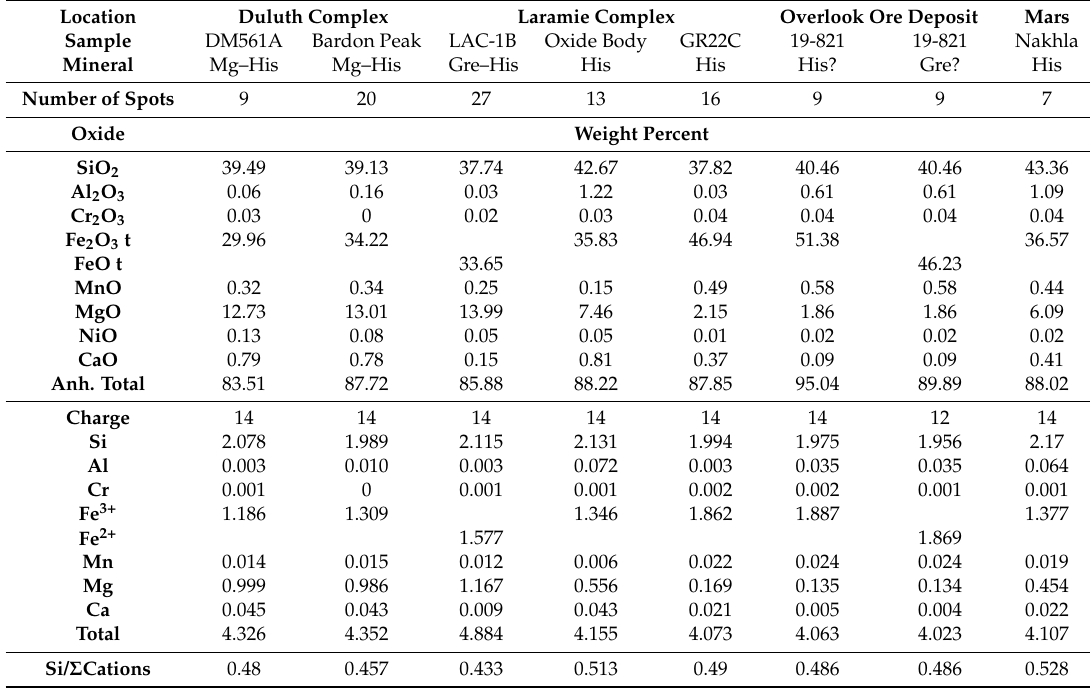
Table 1. Average microprobe analyses of clusters of hisingerite and greenalite. Location Duluth Complex Laramie Complex Overlook Ore